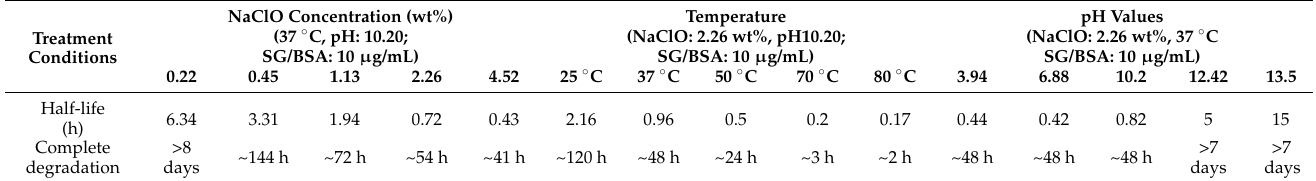
Figure 1. Treatment of SG/BSA dispersions at 37 °C with solutions containing different concentra- tions of NaClO (0.22 wt%, 0.45 wt%, 1.13 wt%, 2.26 wt%, and 4.52 wt%). ( A ) Changes in the amount of SG-CNTs during treatment, estimated from the absorbance at 700 nm. Curves were fitted using the formula Y = Y 0 + A 1 e − x/t1 + A 2 e − x/t2 (Origin software). ( B ) The degradation half-life time of SG-CNTs. SG/BSA is a CNT-dispersion that was obtained by dispersing SG-CNTs in BSA solution (CNTs: 10 µg/mL; BSA: 0.1 mg/mL). Table 1. Time needed for SG/BSA degradation by NaClO under different conditions.